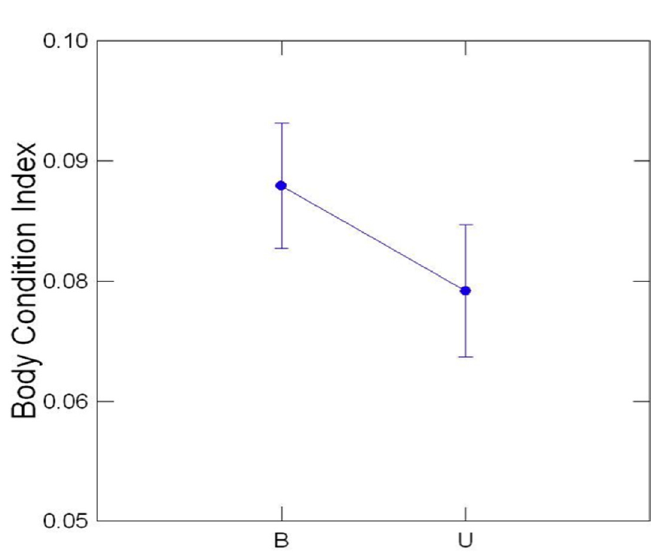
Figure 3. Average body-condition index (BCI), with vertical bars extending to the minimum and maximum values, for buffered (B) and unbuffered (U)